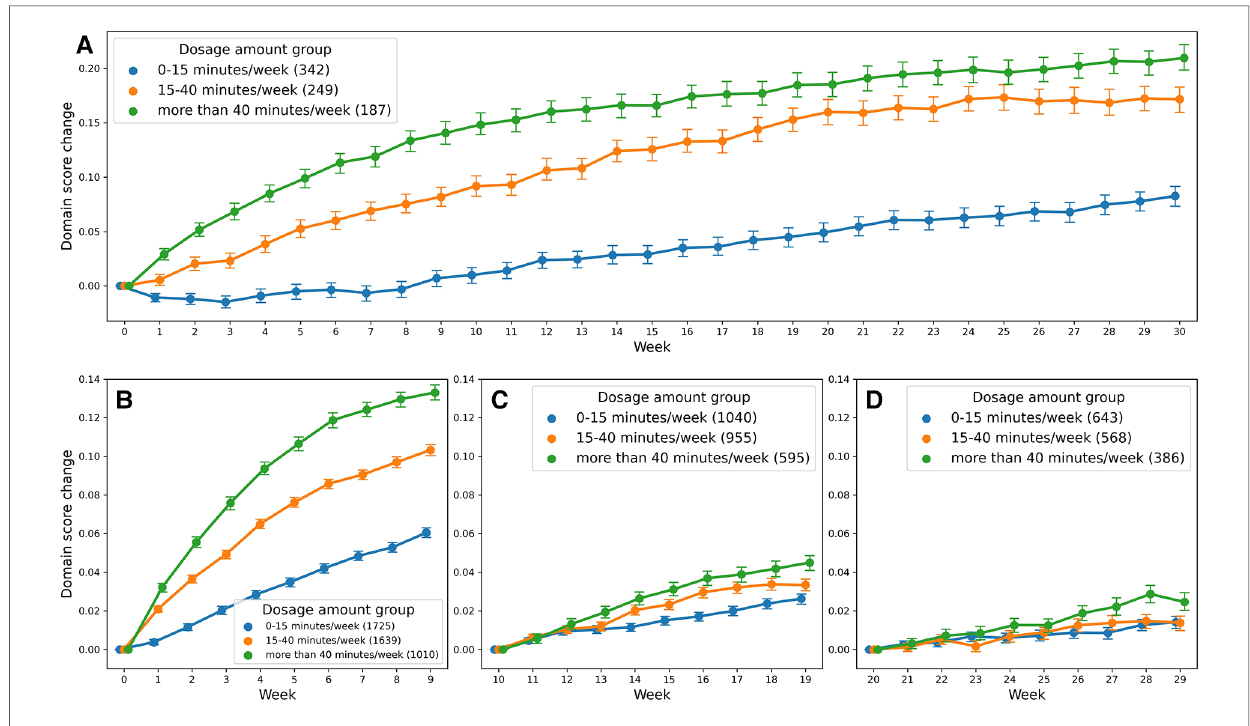
FIGURE 3 Change in domain score as a function of dosage amount group: ( A ) shows the score change for the consistent cohort, and ( B – D ) for the variable cohort.